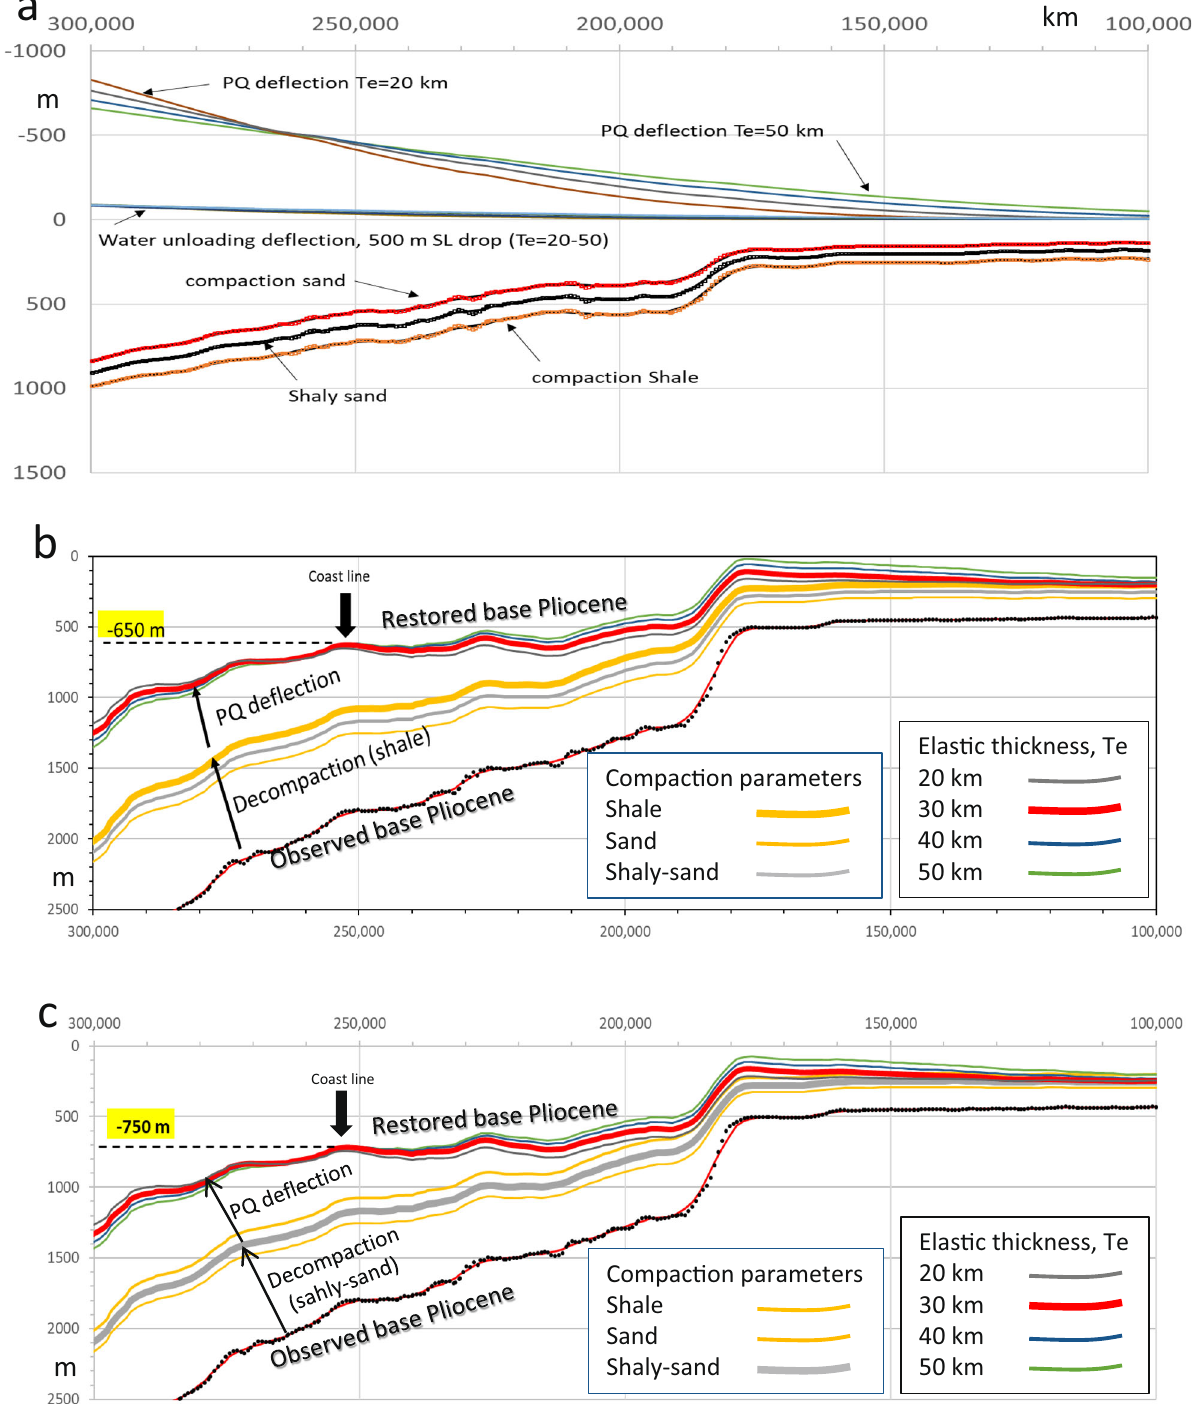
Fig. 5 Uncertainties in river pro fi le restoration. a Calculated subsidence during burial of pre-Pliocene sediments using compaction parameters of shale, sand, and shaly-sand. Calculated de fl ection due to unloading of post-Messinian sediments using elastic thickness Te = 20, 30, 40, and 50 km. b Restoration based on the assumption that pre-Pliocene sediments are mostly shales (same as Fig. 4a). c Restoration based on the assumption that pre- Pliocene sediments are mostly shaly sand. The difference between b and c is 100 m in the sea level restoration (650 m versus 750m,